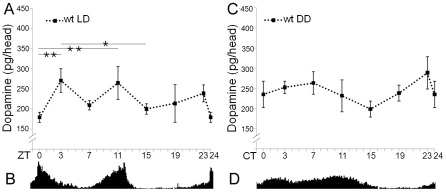
Circadian levels of dopamine in control flies.Dopamine and activity was measured in 6 to 8 days old flies at day 3 or 4 in each condition. Error bars indicate SEM. (A) In LD conditions, control flies show daily cycling of dopamine amount with two peaks at daytime and reduced levels at nighttime. Bars at the top indicate significant difference between two points (*p<0.05, **p<0.01, post hoc Bonferroni test). (B) In this condition the total daily activity plot (n = 32) reveals the typical bimodal pattern of activity with two maximums at the moment of lights on (ZT0) and of lights off (ZT12). (C) When transferred to constant darkness, the cycling of dopamine in control flies is attenuated. (D) Total daily activity plot (n = 47) in DD conditions shows the characteristic sustained activity plateau during the subjective day (CT0-CT12).